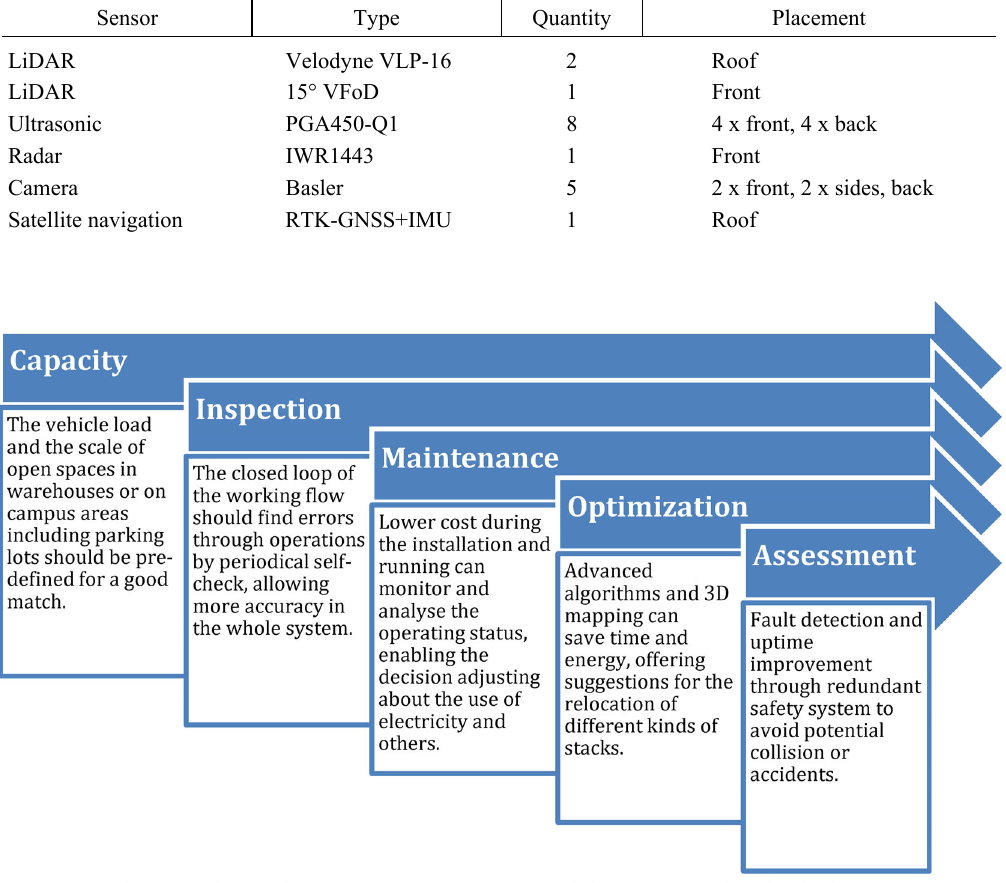
Fig. 2. Criteria for using autonomous vehicles as a service for